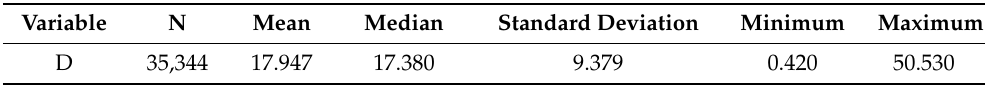
Table 8. Descriptive Statistics for Inter-TAZ